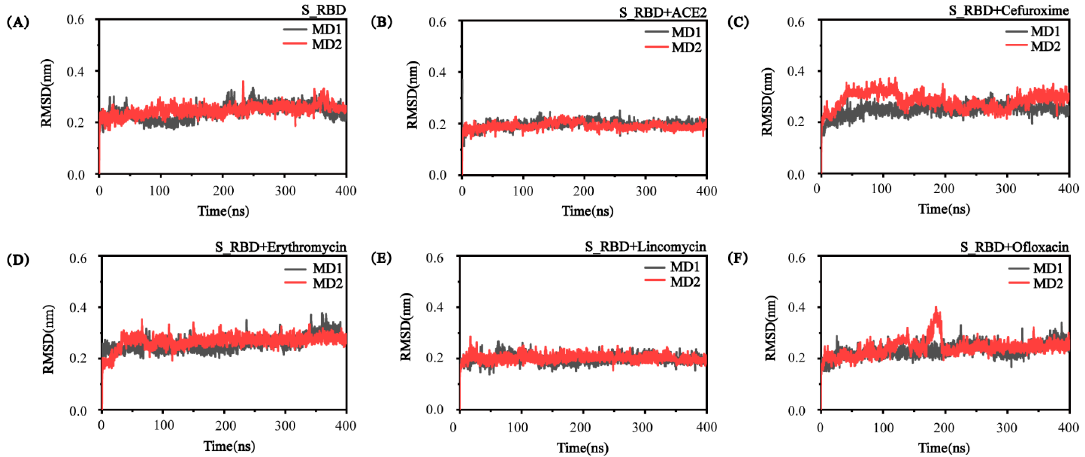
Figure 1. The analysis of the Convergence and Stability of S_RBD. The analysis of backbone RMSD of S_RBD ( A ) for the S_RBD system, ( B – F ) for the S_RBD in the presence of ACE2, Cefuroxime, Erythromycin, Lincomycin and Ofloxacin system, respectively.